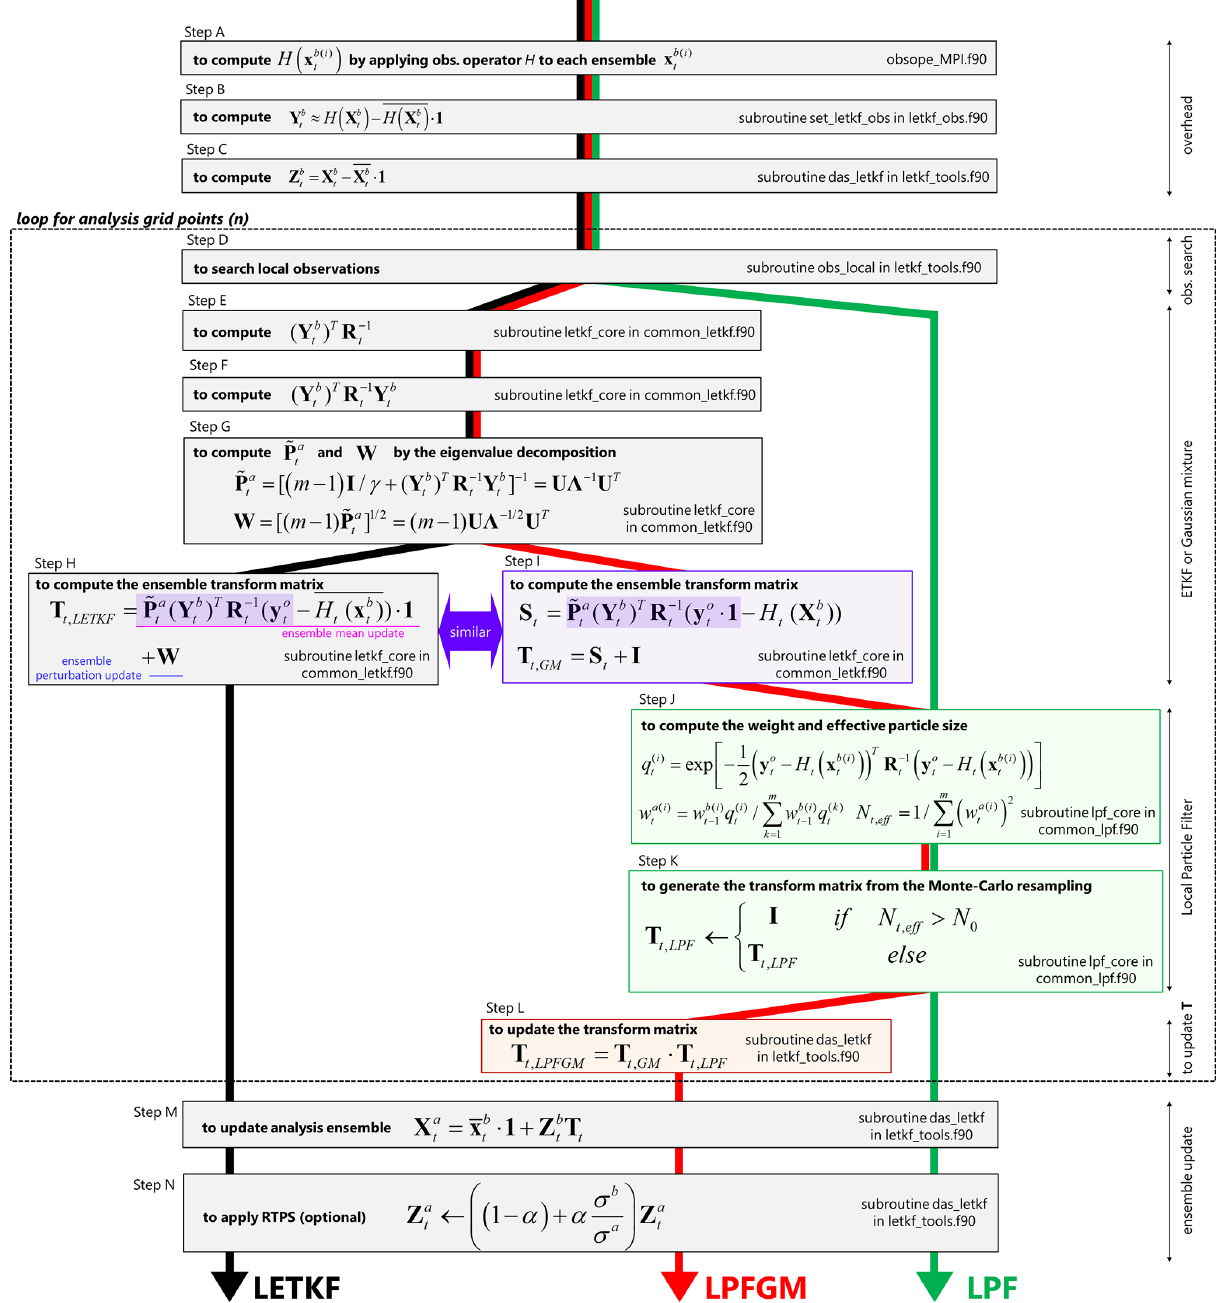
Figure 3. Workflows of LETKF, LPFGM, and LPF. Gray, purple, green, and red boxes represent the components of LETKF, a similar component as in the LETKF, the components of the LPF, and a unique component of the LPFGM, respectively. Subroutines and source files are also described in